Question: Write a single sentence explaining what this figure depicts.
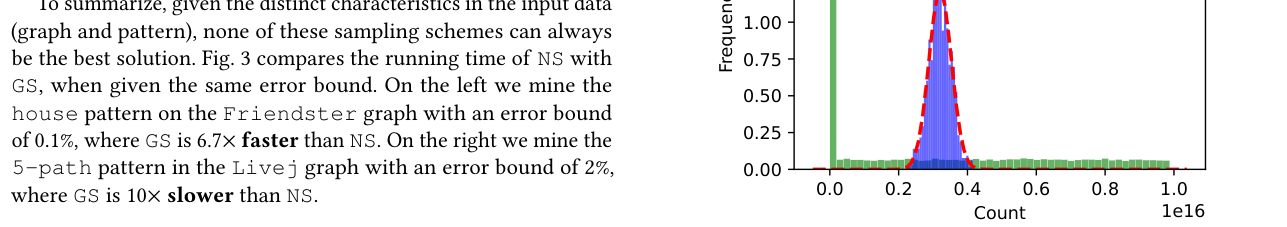
Answer: The normal distribution of the means of sampled counts (i.e. our predicted counts) using neighbor sampling (NS). We ran NS to collect 106 samples on LiveJ, 4-clique. We obtained a predicted count by taking the mean of a random subset of 100 of these underly- ing samples. We simulated 1000 of these predicted counts. Although the underlying distribution of the sampled counts (green bars) is not a normal distribution, their means (purple bars), which are our predicted counts, do follow a normal distribution (dashed red line).